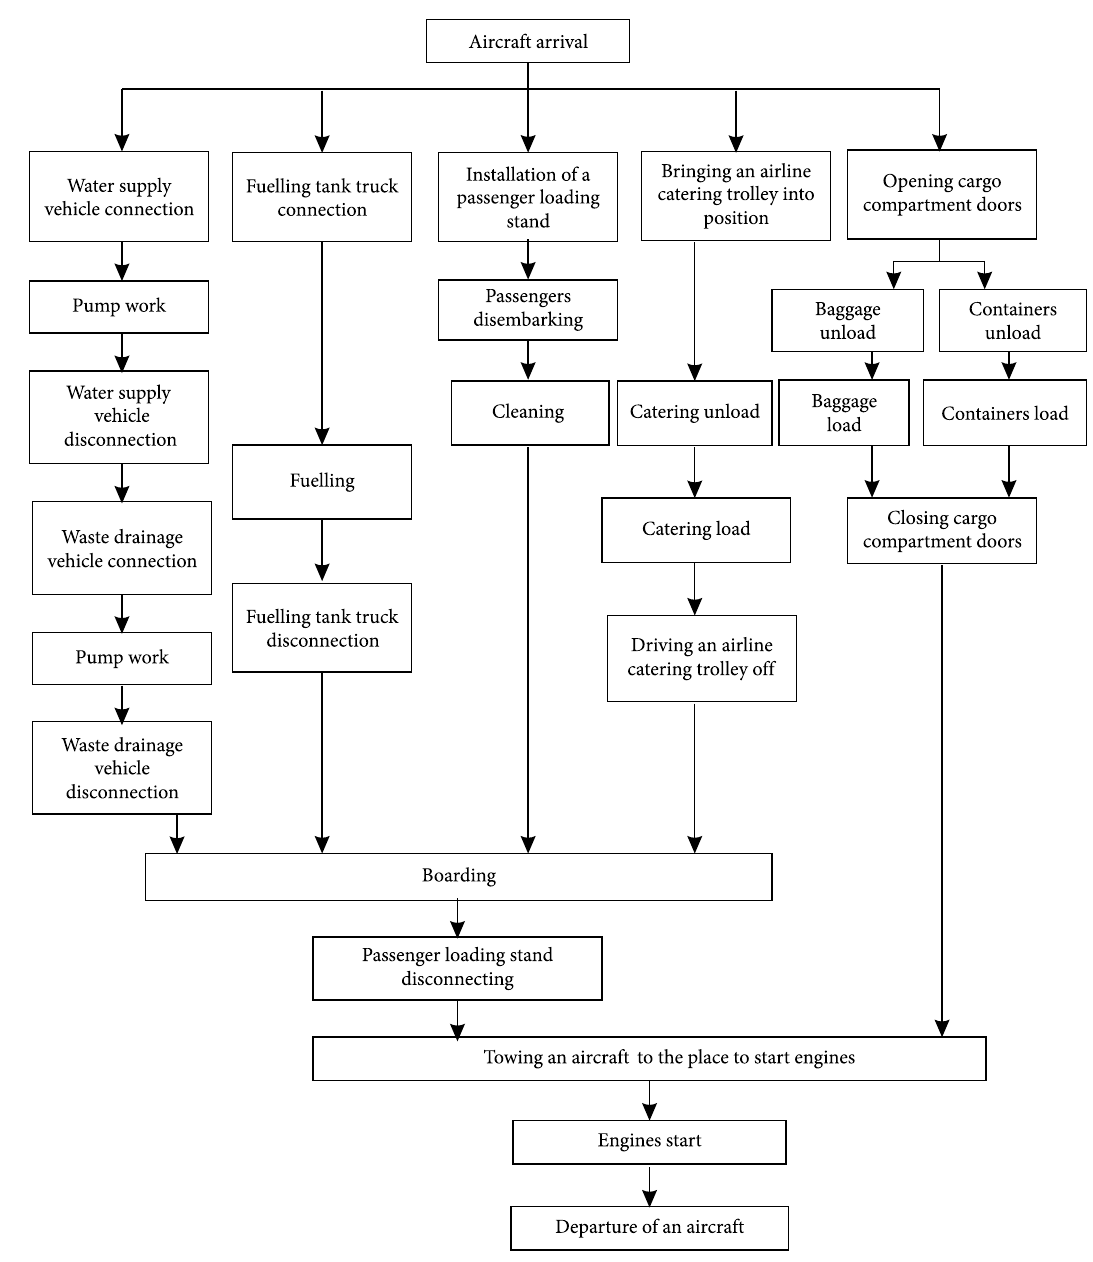
Fig. 1. Model sequence of ground handling for a turnaround flight (based on S. S. Vicente